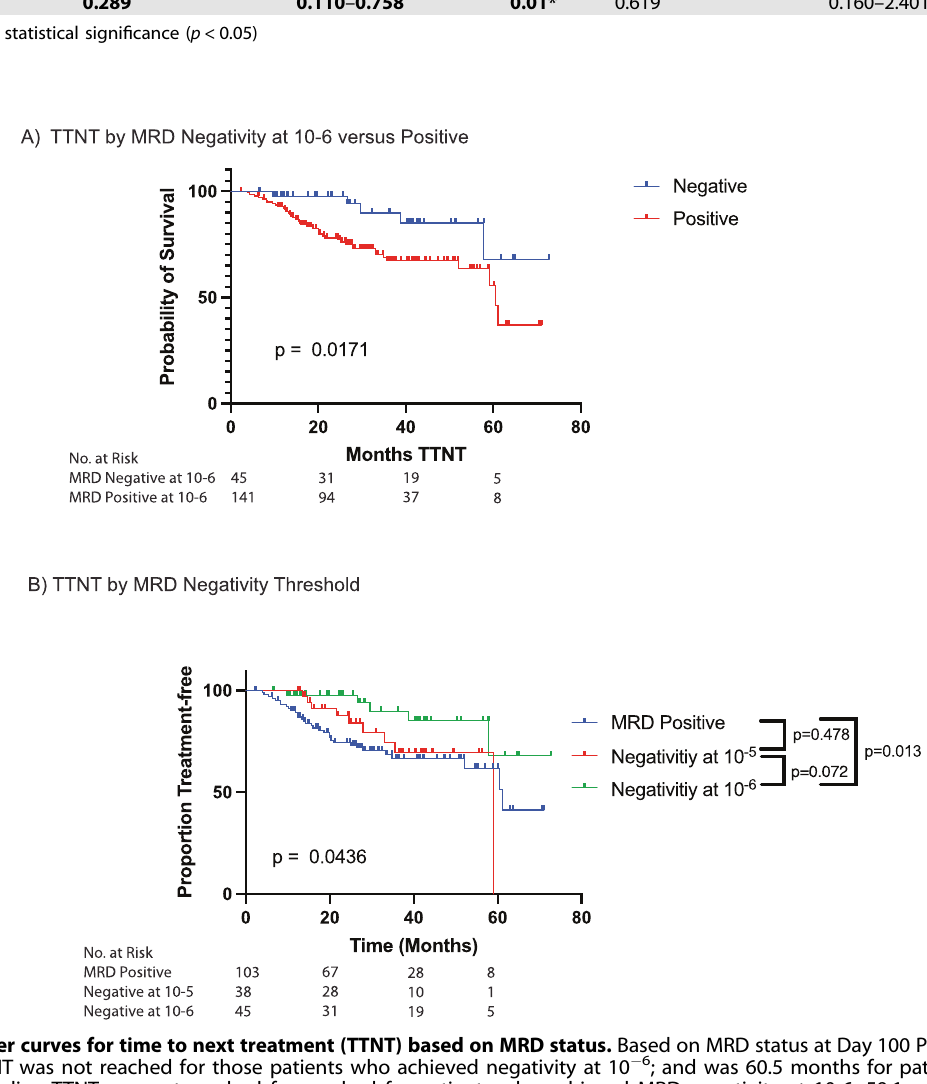
Bold values identify statistical signi fi cance ( p <